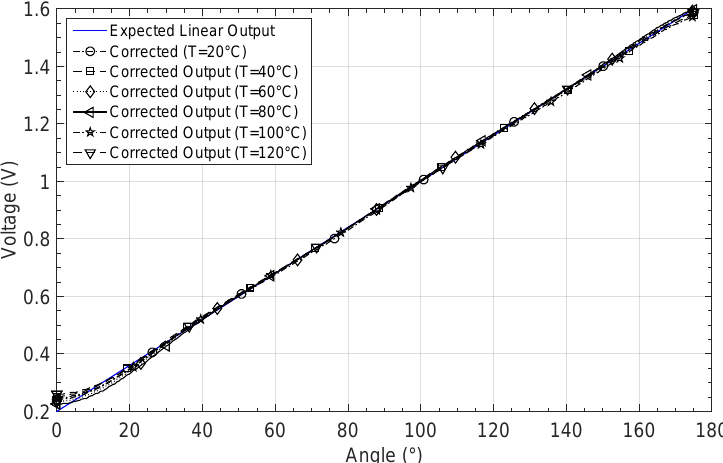
Figure 26. Corrected GMR response by considering different